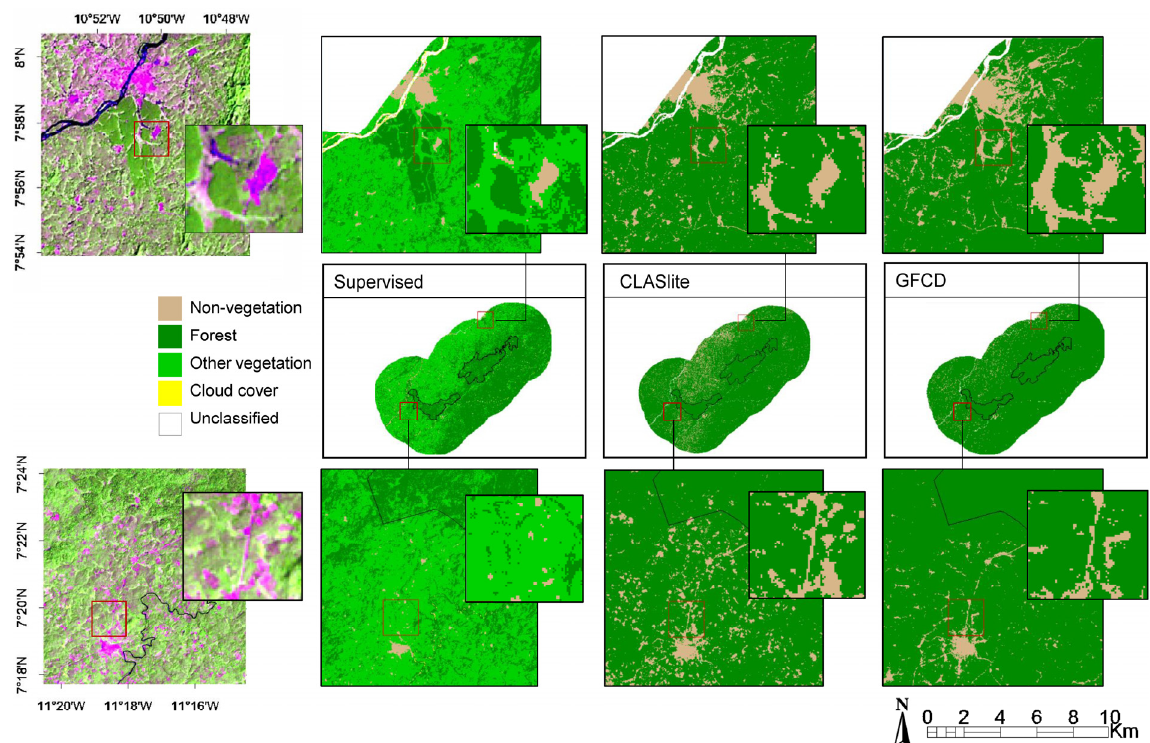
Figure 1. Land-cover maps of Gola and its surrounding 25 km region in early 2001 derived from three classification techniques. The top row of zoomed-in panels depicts a palm plantation; the bottom row of zoomed-in panels depicts a small town and its surrounding area. The two panels in the left-most column are Landsat reflectance images represented in R = Band 5 (1.55–1.75 μ m), G = Band 4 (0.77–0.90 μ m), and B = Band 3 (0.63–0.69 μ m). For the Carnegie Landsat Analysis System lite (CLASlite) and Global Forest Change dataset (GFCD) maps, only the Non-vegetation and Forest categories from the figure key